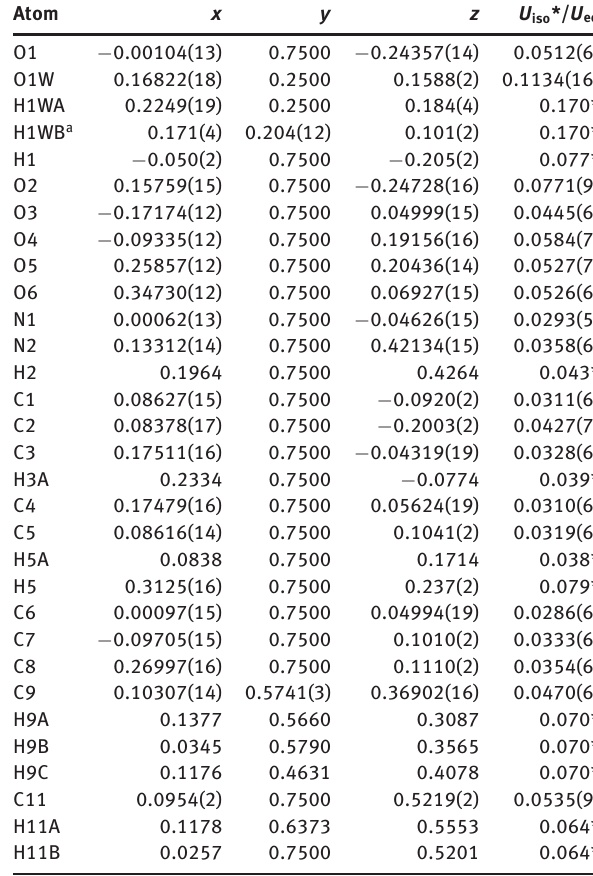
Table 2: Fractional atomic coordinates and isotropic or equivalent isotropic displacement parameters (Å 2